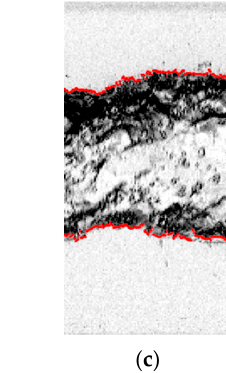
Figure 11. MATLAB image processing steps. ( a ) Binarized flow picture after color inversion. In the image, the interface between the fluids is represented in white and has value 1, and the locations inside the gas core and the water annulus are represented in black, with value 0. ( b ) Image obtained after the removal of small (smaller than 100 px) white regions required for proper tracking of the interface between the fluids. ( c ) interface tracked and plotted in red on top of the original image. Once the interface position over the length of an image is obtained, a routine to correct each point (pixel on the interface) is performed based on the refraction suffered by the light rays reaching the camera.